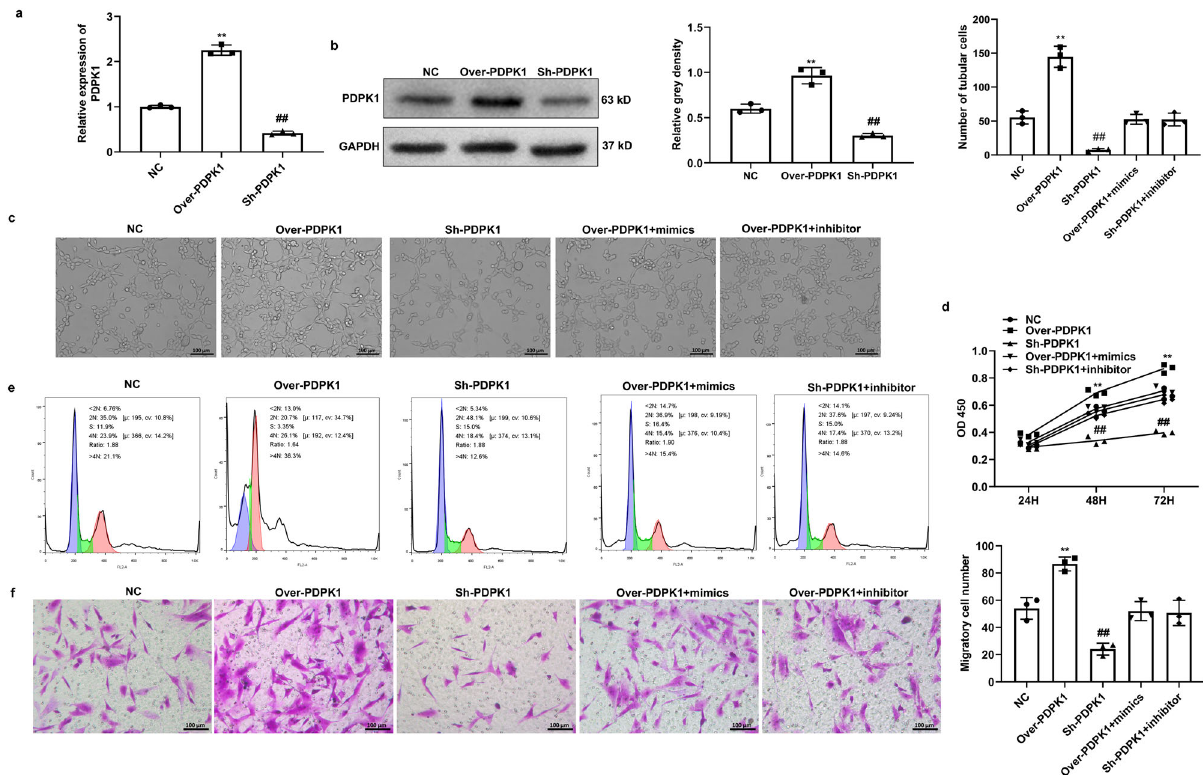
Fig. 7 miR-1178-3p-mediated PDPK1 regulated angiogenesis of CMECs and proliferation and migration of VSMCs. a , b Expression of PDPK1 was detected by qRT – PCR and western blotting by overexpressing or suppressing of PDPK1 in CMECs, respectively, GAPDH served as a control; cc Tube formation analysis was used to detect capillary-like structures in the PDPK1 overexpression or suppression group and rescued by miR-1178-3p; Bar = 200 μ m; d CCK-8 assay was used to detect the viability of VSMCs in the PDPK1 overexpression or suppression of group and rescued by miR-1178-3p at 24 h, 48 h and 72 h; E Flow cytometry was used to detect the cell cycle of VSMCs in the PDPK1 overexpression or suppression group and rescued by miR-1178-3p; f Migration of VSMCs was detected by Transwell assay when PDPK1 overexpressed or suppressed and rescued by miR-1178-3p, Bar = 200 μ m. Data are mean ± SD. ** P < 0.01, Over-PDPK1 group vs. NC group; ## P < 0.01, Sh-PDPK1 group vs. NC